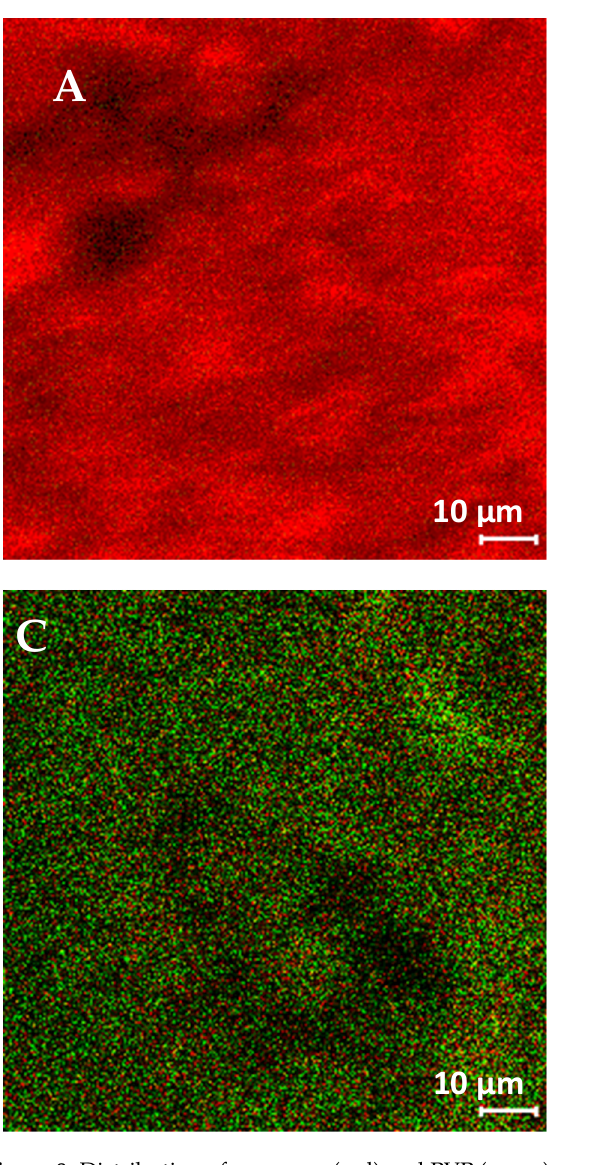
Figure 8. Distribution of naproxen (red) and PVP (green) measured by ToF-SIMS on the particle surface of ( A ) crystalline naproxen; ( B ) neat PVP; ( C ) 2FN ASD and ( D ) 3FN ASD (scale bar represents 10 µ m). Table 1. Surface composition of the naproxen-PVP dispersions (2FN and 3FN) as measured by XPS (mean ± SD, n = 5).